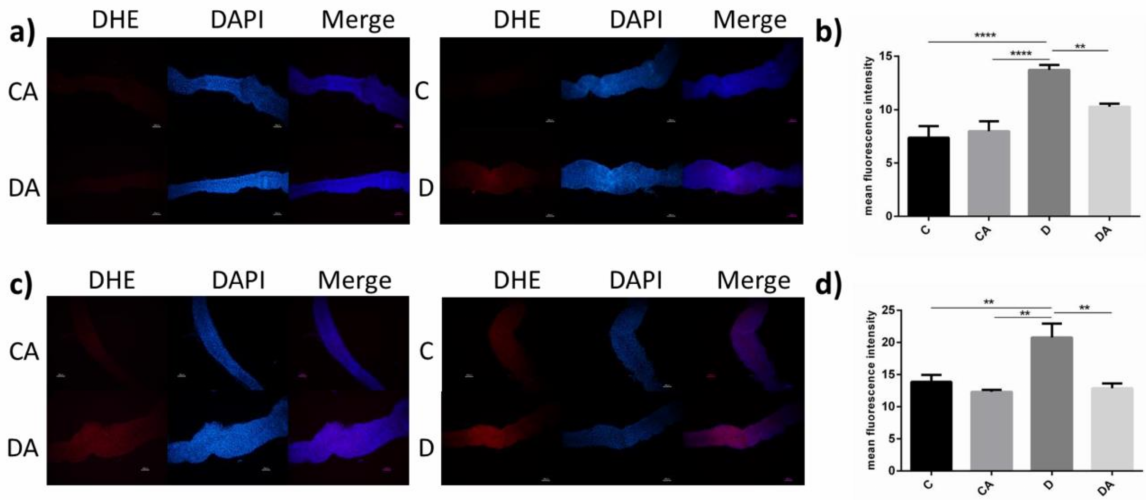
Figure 5. Effects of BANCs on the ROS content of intestinal epithelial cells from female D. melanogaster with DSS-induced inflammation. C, CA, D, and DA represent the blank control group, BANC control group, inflamed group, and BANCs + inflamed group, respectively. The midguts of normal ( a , b ) and axenic ( c , d ) female D. melanogaster from the four groups were stained for DHE (red) and DAPI (blue). Scale bar: 50 µ m. Data from triplicate repetitions are expressed as the means ± SEMs. Statistical significance: ** p < 0.01, **** p <